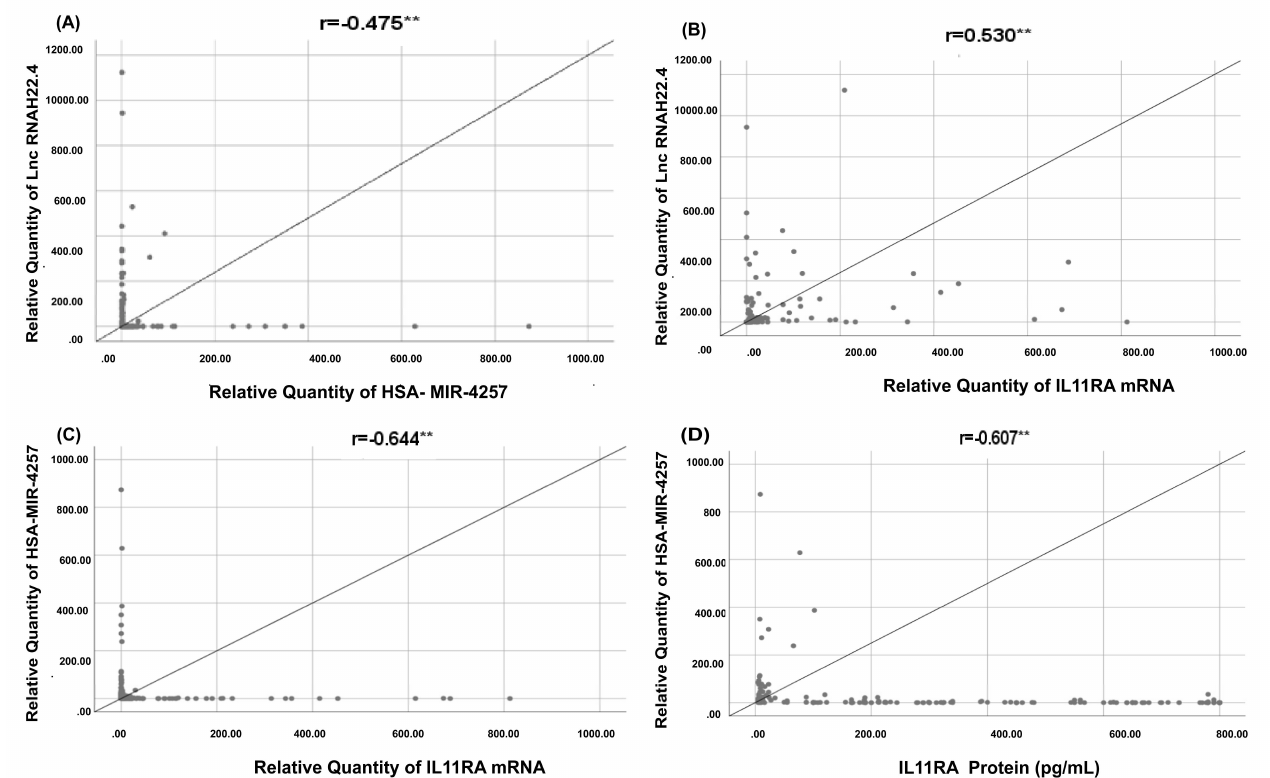
Figure 5. Correlations among IL11RA molecular network and IL11RA protein. As shown each two parameters are correlated together ( A ) the relative quantity of has-miR-4257 and Ln RNA H22.4, showing increase in the Long nc RNA compared to the miRNA negative correlation, ( B ) The correlation between the IL-11R mRNA and the Lnc RNA H22.4, showing that positive correlation between the two variables, ( C ) The correlation between the IL-11R mRNA and has-miR-4257, showing negative correlation and finally ( D ) the correlation between IL 11RA protein and the has-miR-4257, which shows negative correlation and so as the IL-11RA increase the has-miR-4257 decrease. ** are Statistically